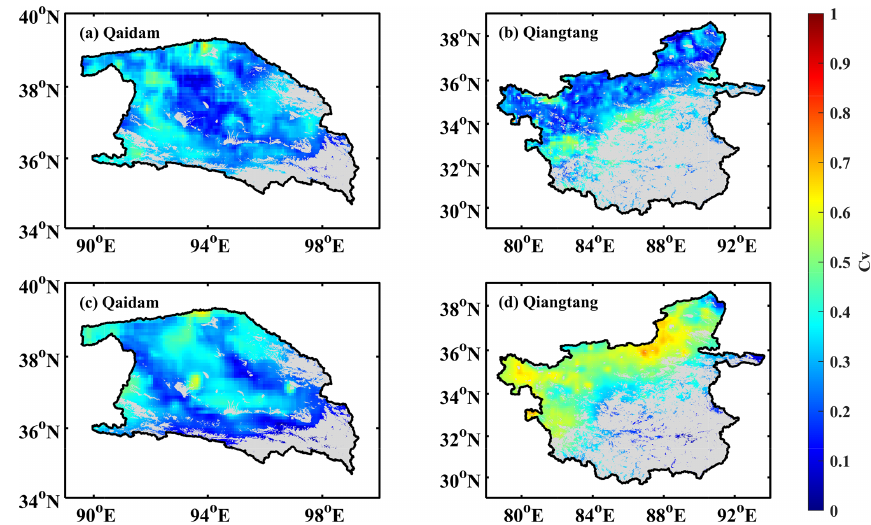
Figure 10. Maps of the coefficients of variation of monthly average soil evaporation from 2003 to 2011 for barrens estimated by (a, b) the P-LSH θ algorithm driven by five soil moisture datasets and (c, d) the P-LSH P algorithm driven by five precipitation datasets in (a, c) the Qaidam Basin and (b, d) the Qiangtang Plateau. The gray shading indicates the non-barren areas within the